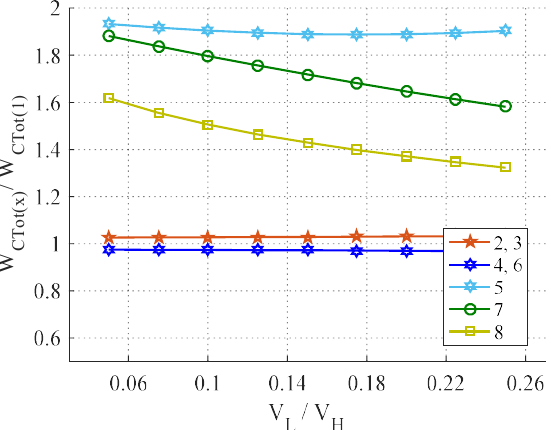
Figure 7. Total energy stored in inductors, as a function of the voltage conversion ratio (converters 1–8 described in Table 1).